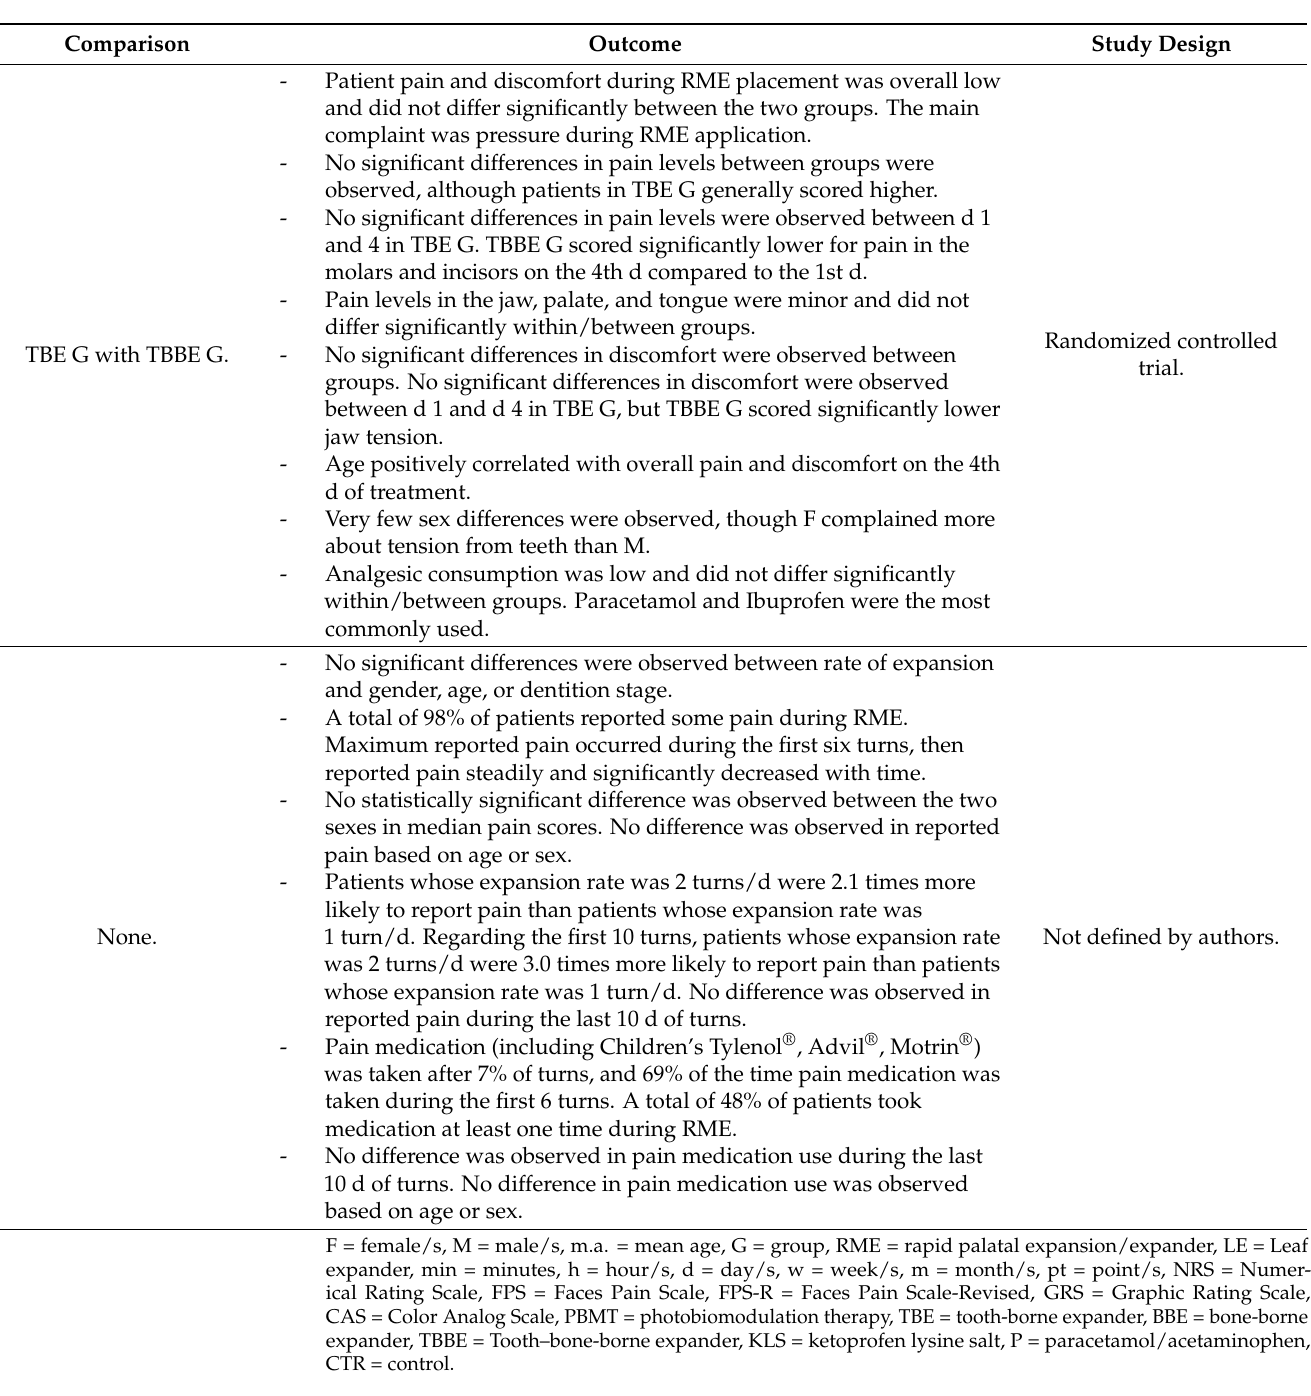
Comparison Outcome Study